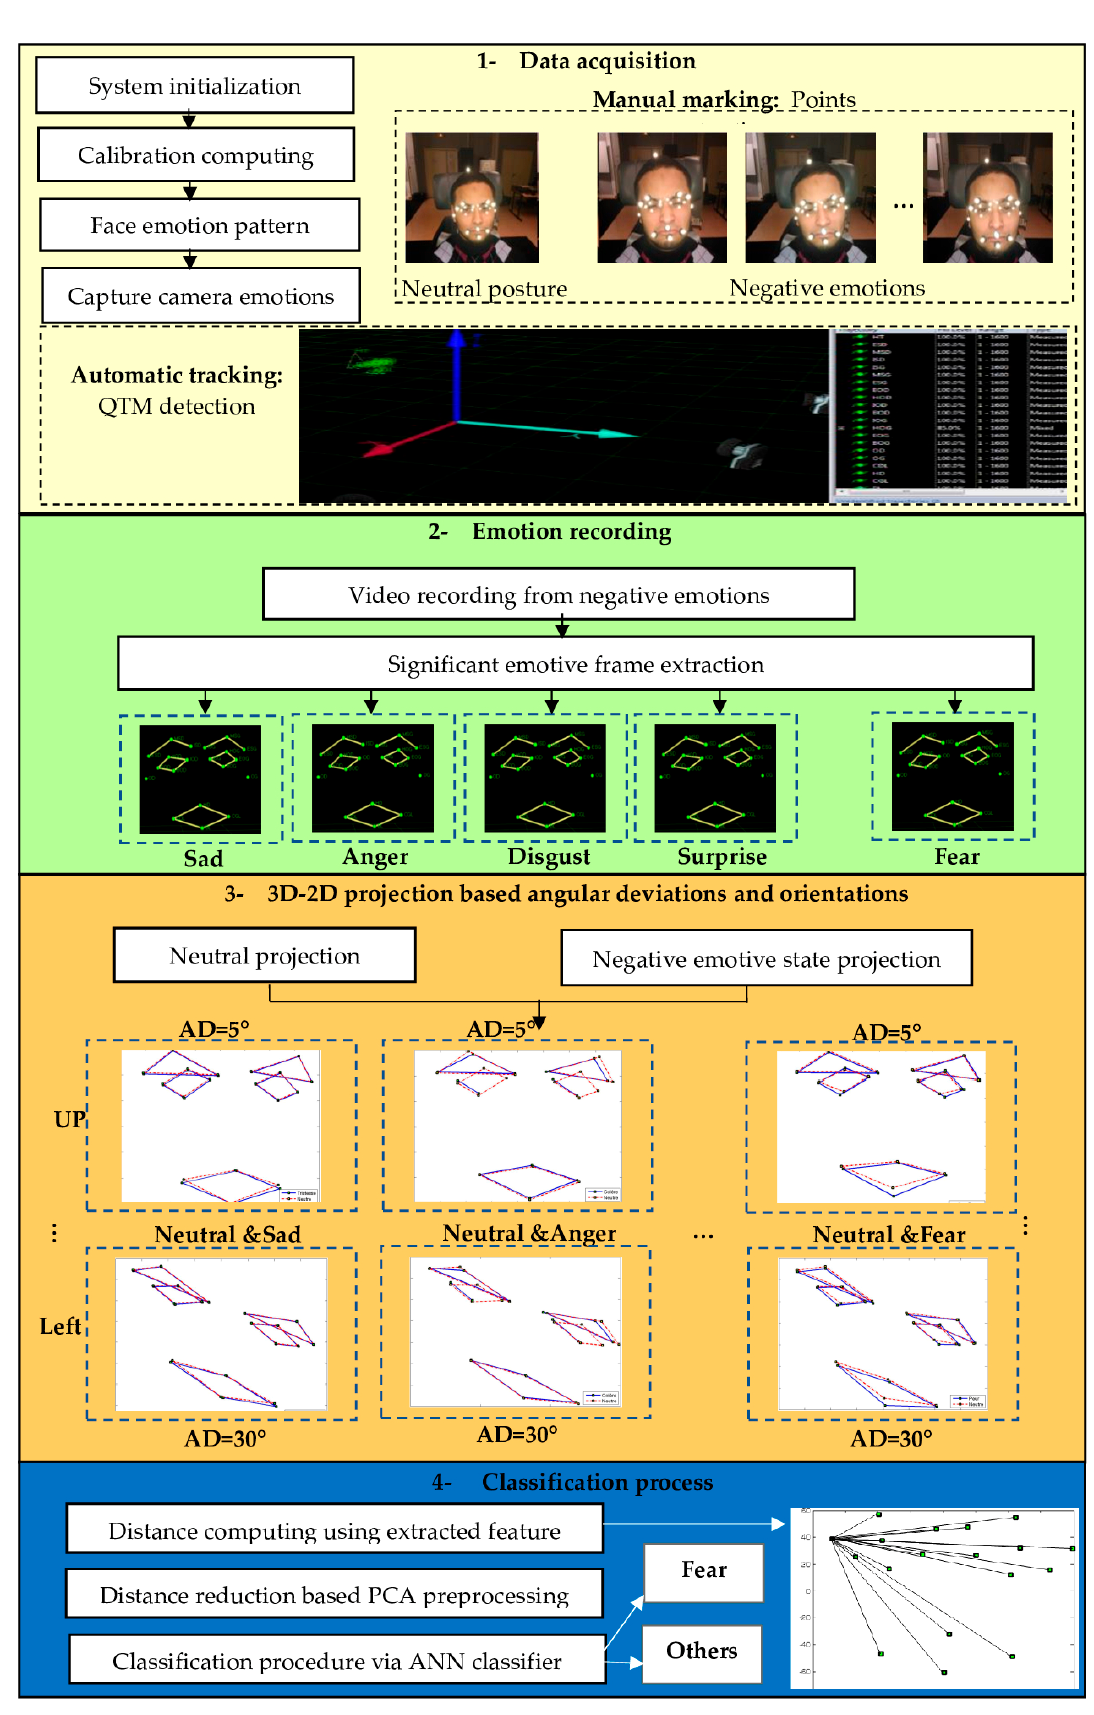
Figure 1. Representation of the proposed methodology.